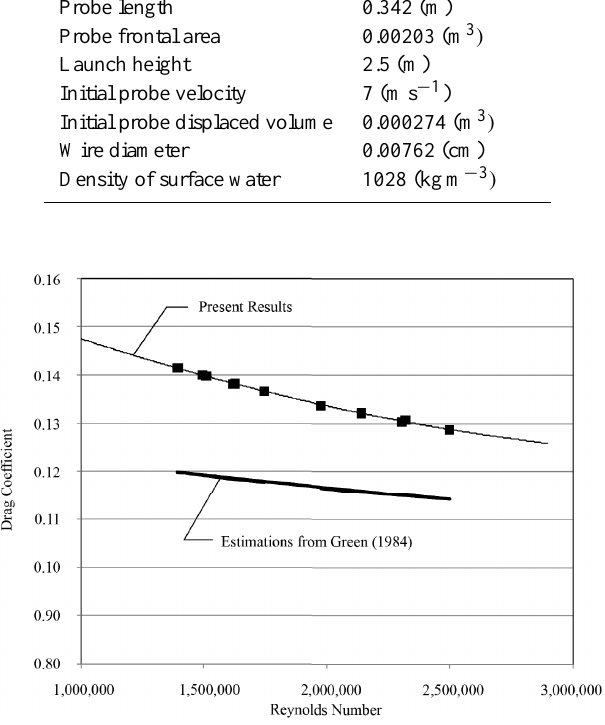
Fig. 4 – Comparison of present drag coefficient results with those from Green (1984). Fig. 4. Comparison of present drag coefficient results with those from Green